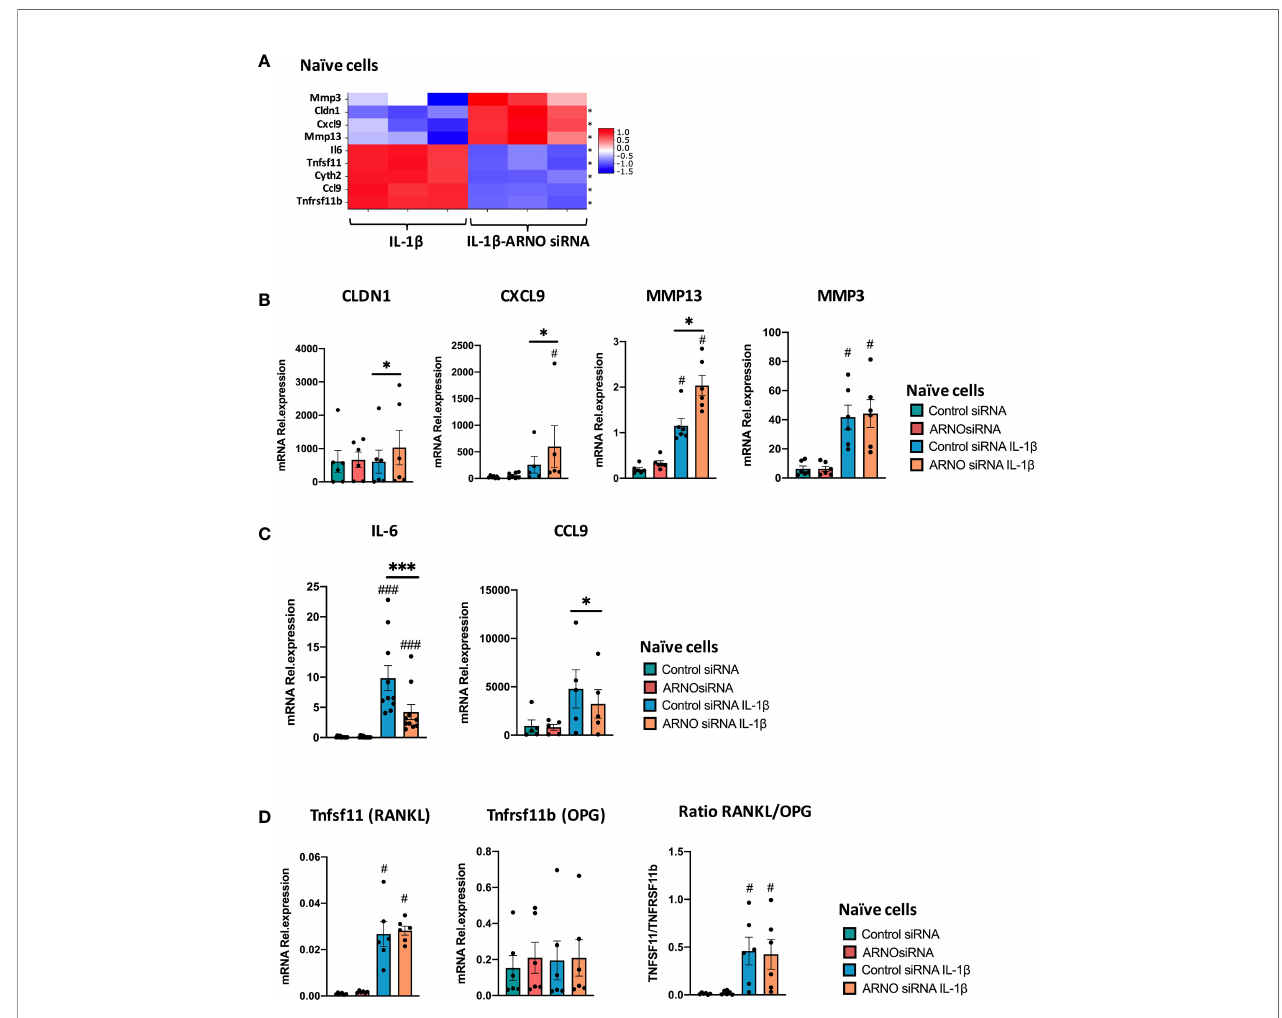
FIGURE 6 | ARNO knock-down remodels the type of IL-1 b -mediated in fl ammatory response. (A) mRNA expression as detected by RNA-Seq from Figure 5 for ARNO (Cyth2), IL-6, CXCL9, CCL9, CLDN1, MMP3, MMP13, TNFRSF11b and TNFSF11. Differentially expressed genes with a adjp < 0.01 are shown by *. (B – D) RNA was isolated from unstimulated and IL-1 b -stimulated naïve SFs upon Allstars/ARNO siRNA transfection. Relative mRNA expression of genes shown in (A) was evaluated by RT-qPCR using the DD C t method and actin as housekeeping gene. (B) CLDN1, Cxcl9, MMP13, MMP3, (C) IL-6, Ccl9, and (D) TNFRSF11b and TNFSF11 mRNA relative expression. For (B – D) , each dot represents one independent experiment (analysed in triplicate), error bars represent SEM (n ≥ 5), *p < 0.05, ***p < 0.001 versus respective siRNA control, # p < 0.05, ### p < 0.001 versus unstimulated control, statistical signi fi cance was evaluated by the Mann-Whitney